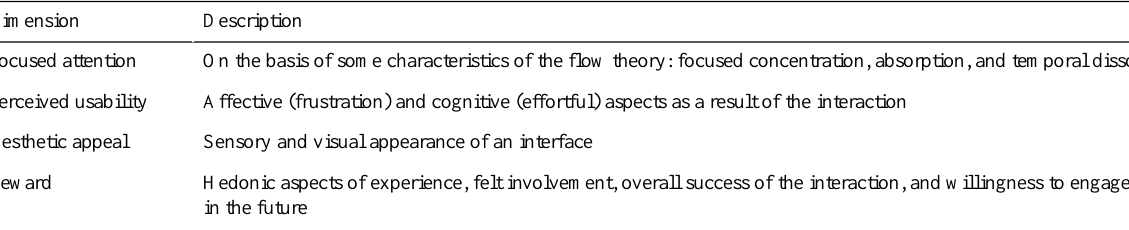
Table 1. User engagement scale